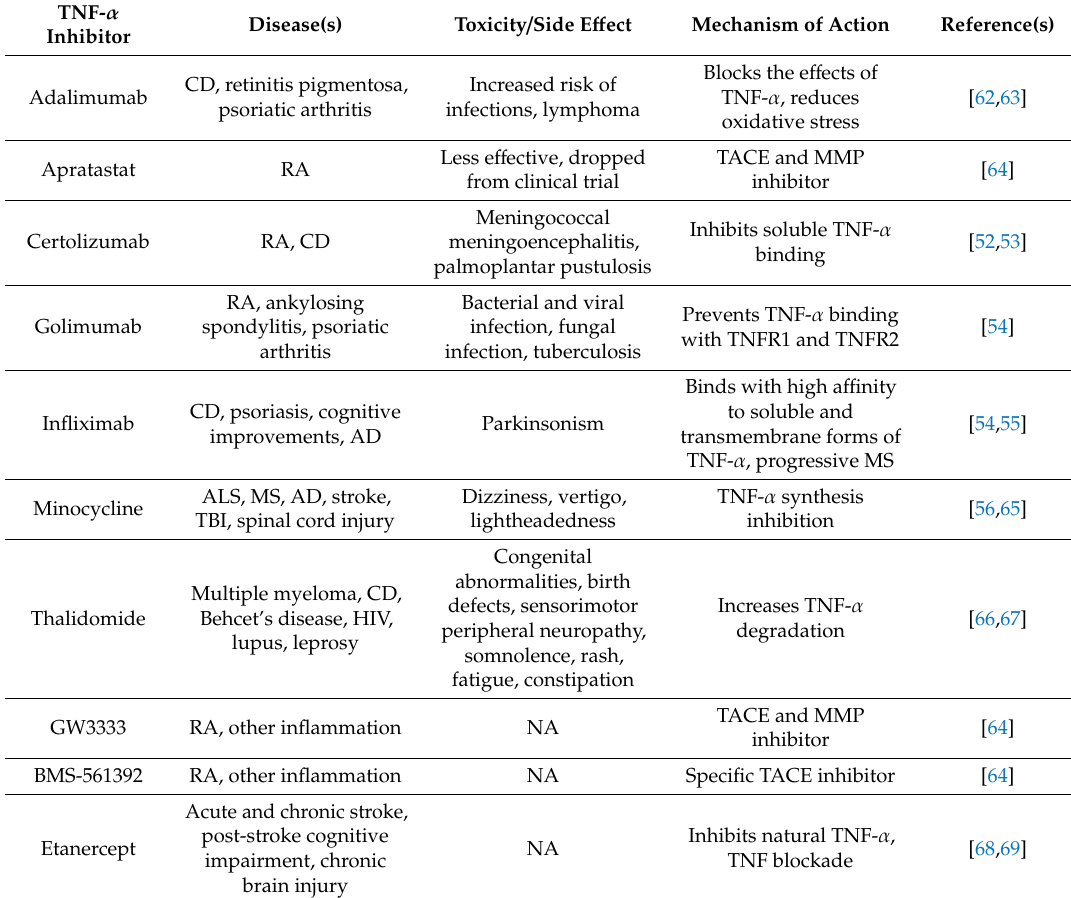
Table 1. Commercially available TNF- α inhibitors prescribed for several inflammatory